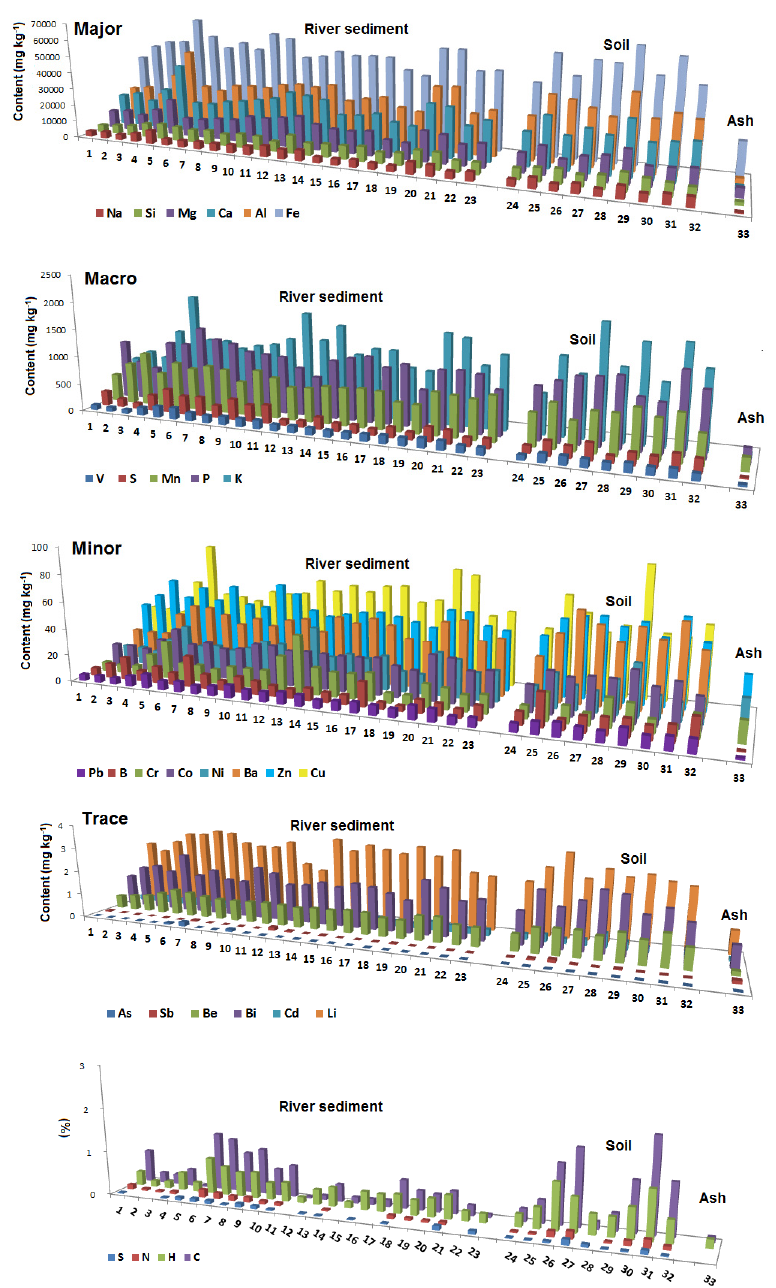
Figure 2. Level of concentrations of investigated element in river sediments and soil at different locations indicated on the Y -axis.